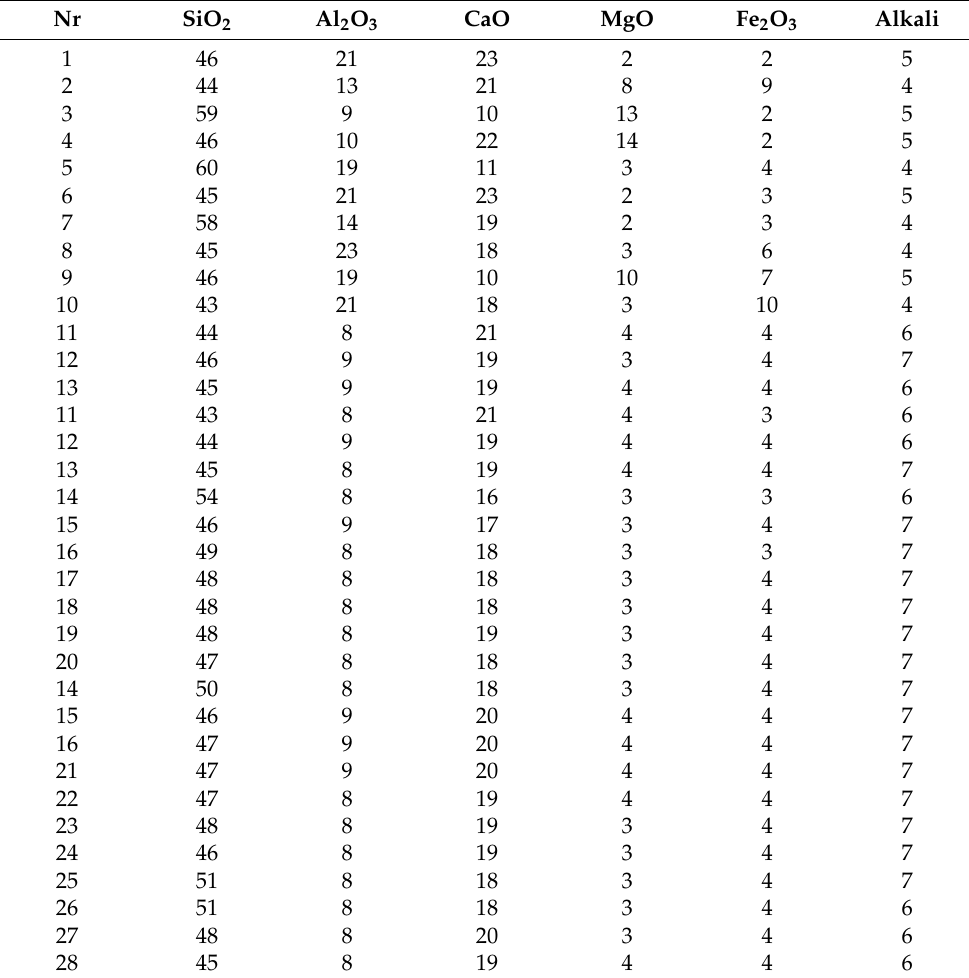
Table 3. Examples of oxide compositions of glasses melted according to the research plan